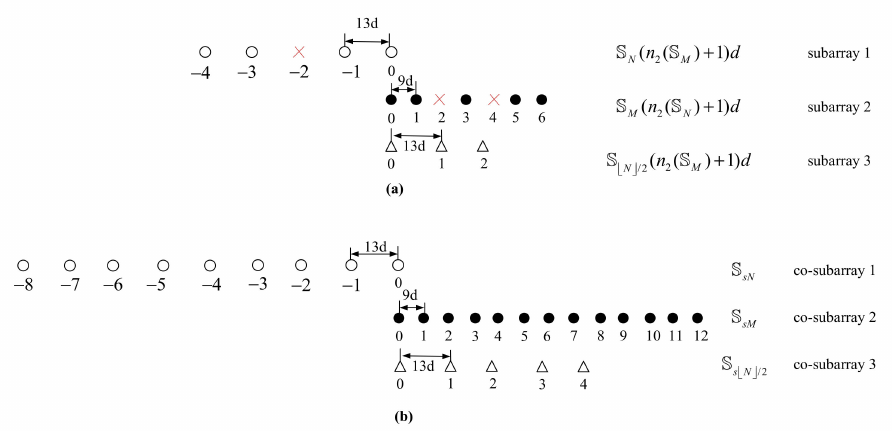
Figure 2. ( a ) Physical sensors location S ; ( b ) co-array S sc = S sM ∪ S sN ∪ S s (cid:98) N /2 (cid:99)